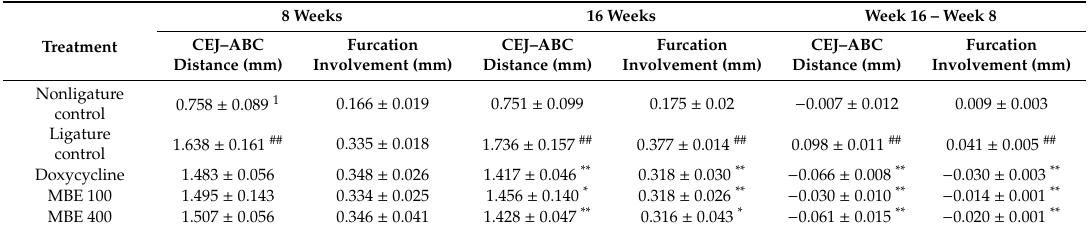
Figure 1. E ff ects of Magnolia biondii extract (MBE) on alveolar bone loss and tissue damage. The images of bone surrounding three molars were analyzed by three-dimensional microcomputed tomography and are shown here representative of each group: ( A ) non ligature-control, ( B ) ligature-control, ( C ) doxycycline 20 mg / kg, ( D ) MBE 100 mg / kg, and ( E ) MBE 400 mg / kg. The scale bar = 1.0 mm. Table 1. E ff ects of MBE on cement–enamel junction (CEJ)–alveolar bone crest (CEJ–ABC) distance and furcation involvement with micro-CT images analysis in periodontitis rats .